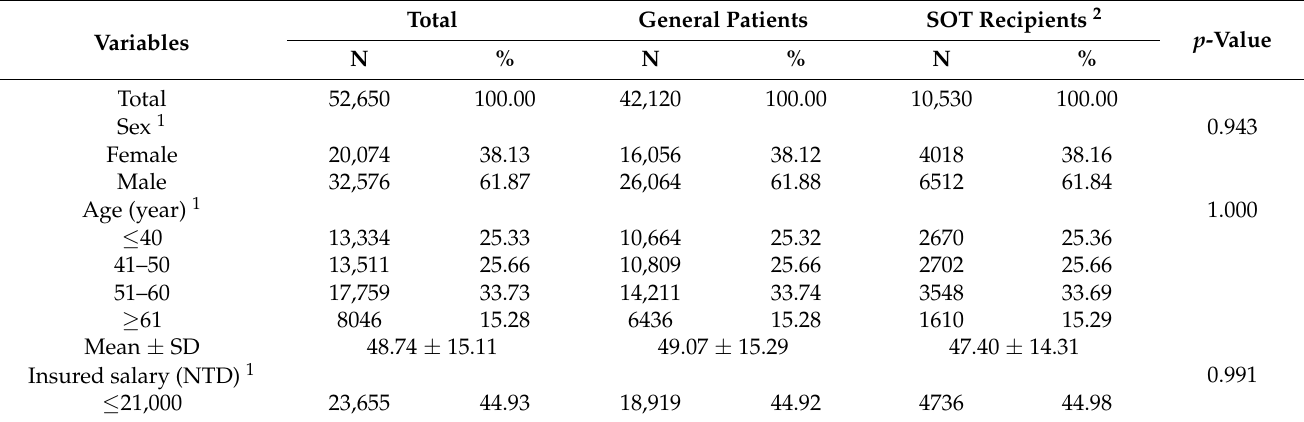
Table 1. Baseline characteristics of solid organ transplant recipients after